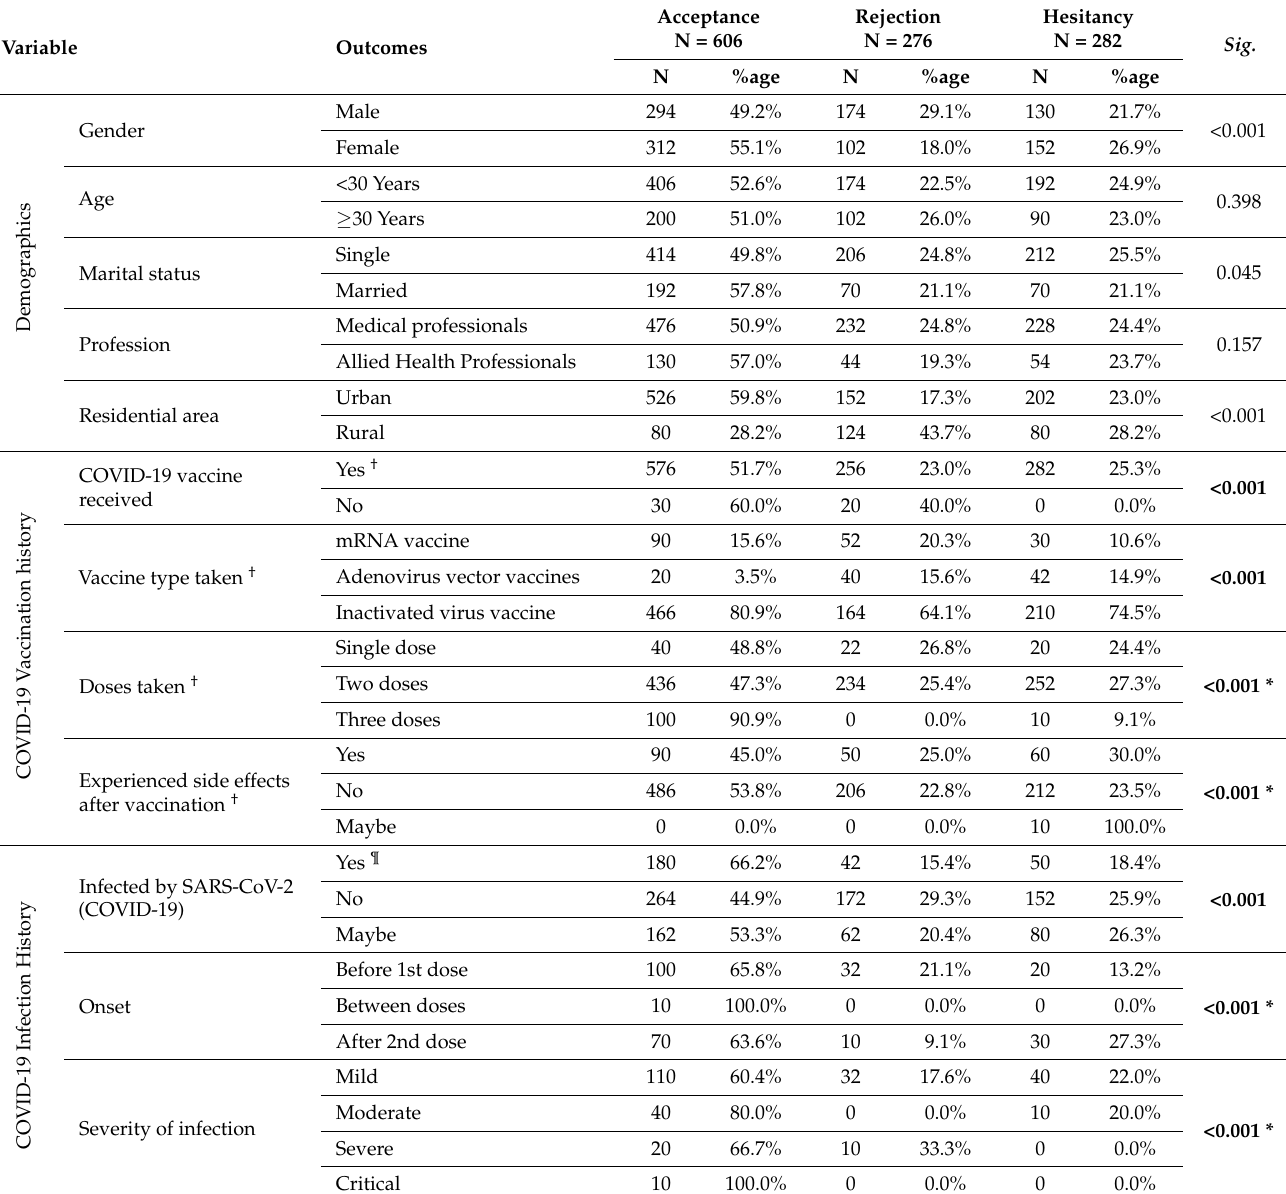
Table 4. The association of demographics, COVID-19 disease, and vaccination history towards attitudes of participants, regarding booster dose of COVID-19